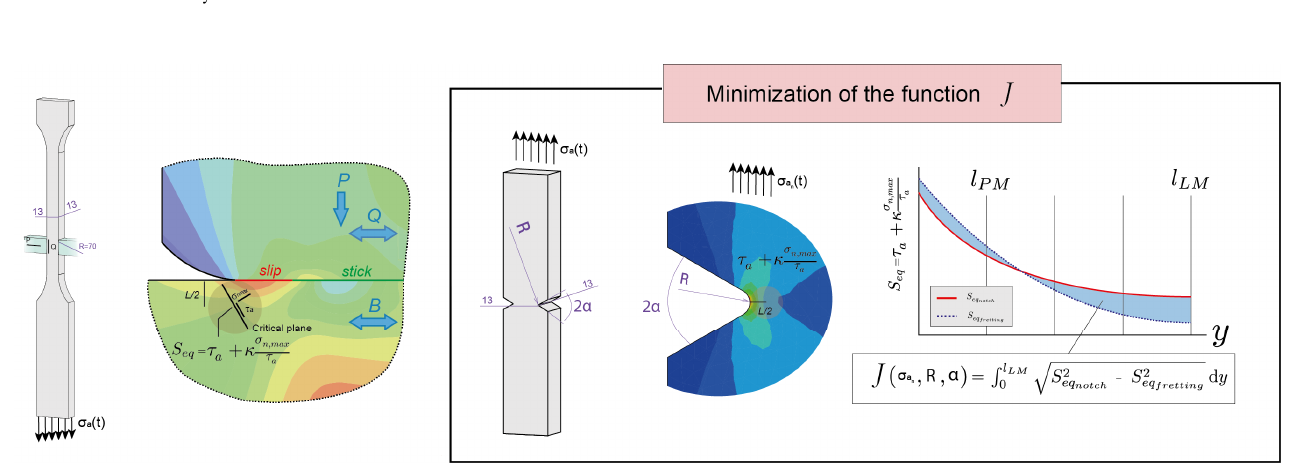
Figure 1: Scheme of the methodology proposed to find equivalent notch/fretting fatigue configurations.